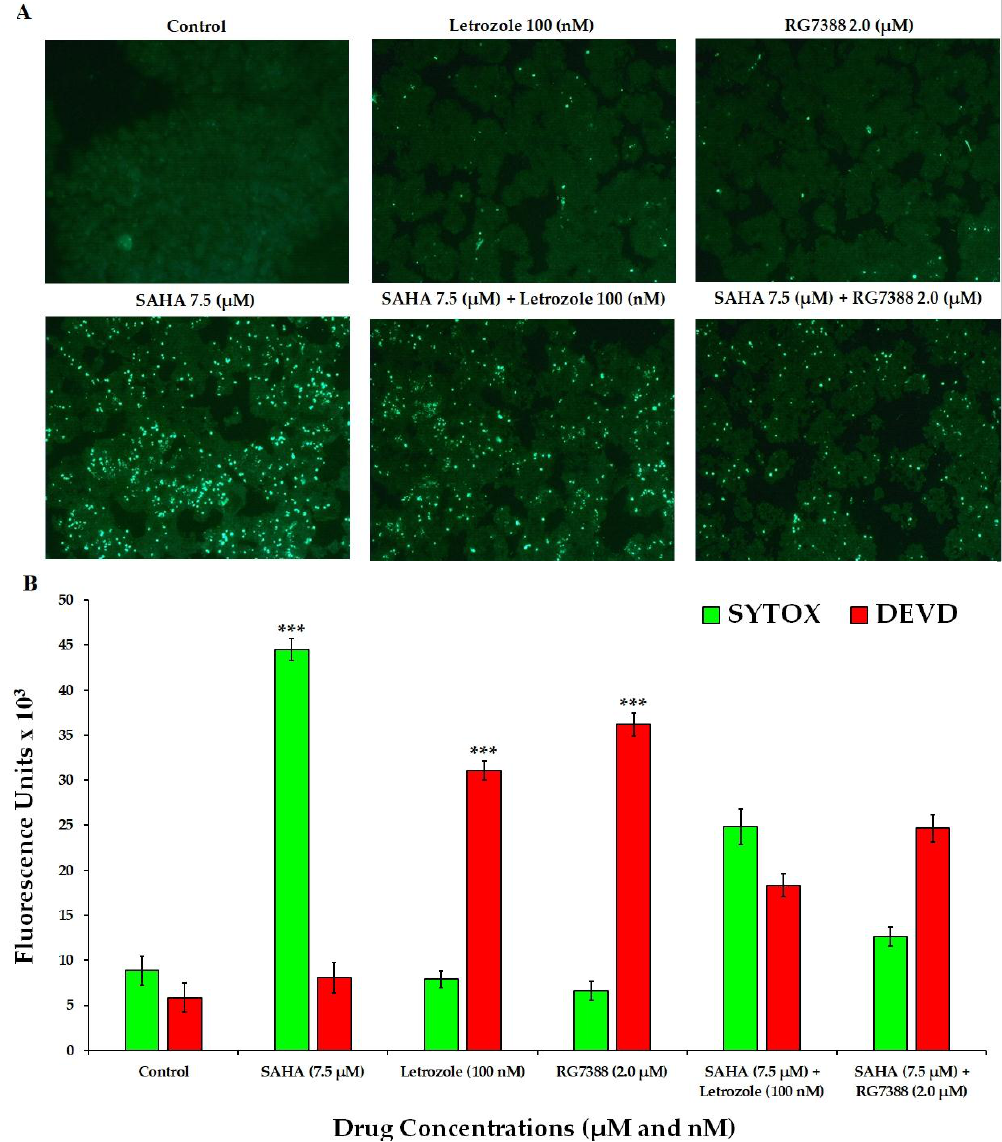
Figure 3. Analysis of necroptosis versus apoptosis in MCF-7 cells. ( A ) Confirmation of necroptosis versus apoptosis in MCF-7 cells treated with SAHA (7.5 µ M), letrozole (100 nM), and RG7388 (2.0 µ M) individually and in combinations (SAHA + letrozole and SAHA + RG7388) using the SYTOX green staining method. ( B ) Analysis of necroptosis and apoptosis in MCF-7 cells with SAHA (7.5 µ M), letrozole (100 nM), and RG7388 (2.0 µ M) individually and in combinations (SAHA + letrozole and SAHA + RG7388) for 24 h, with SYTOX green and DEVD- amc using a spectrofluorometric assay in a 96-well plate. Data are presented in the bar graph are mean ± SD, from minimum of three independent experiments. The level of significance is indicated as *** p < 0.001 compared to control.